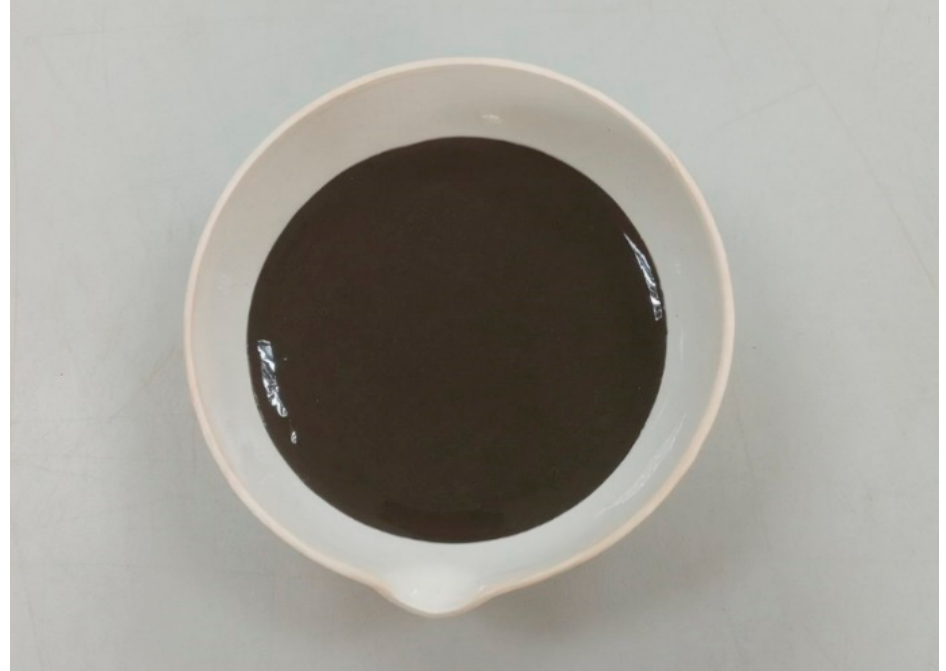
Figure 2. POFA-based geopolymer before mixing with soil. Table 3. Mixing proportions of different